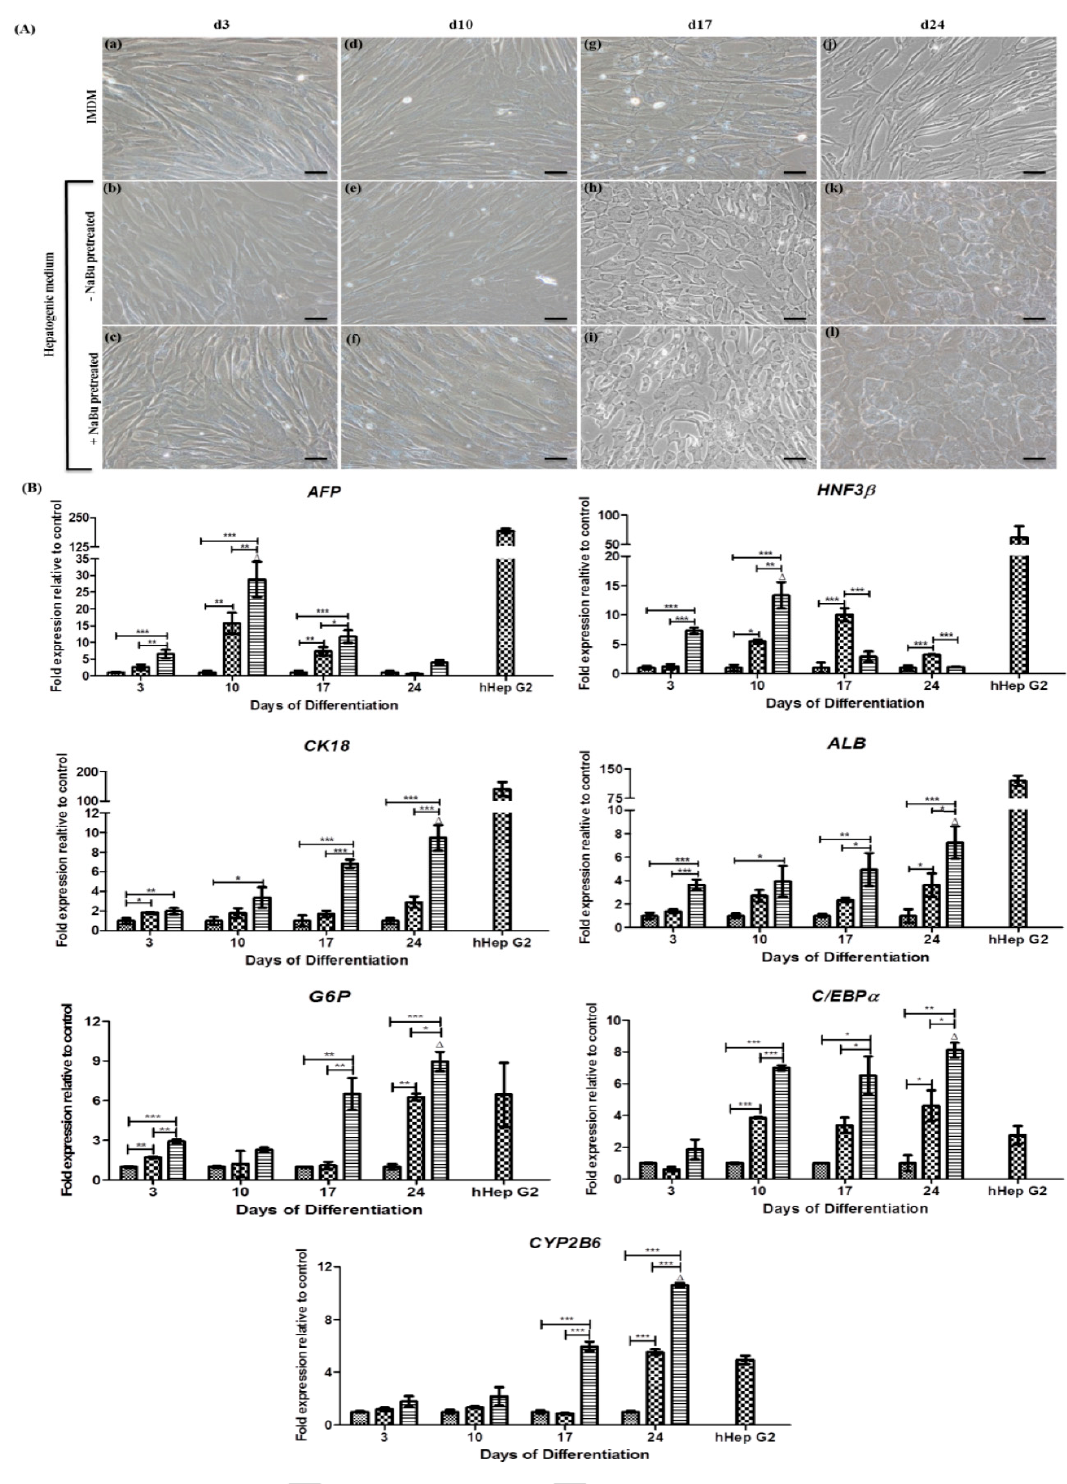
Figure 5. The influence of sodium butyrate (NaBu) along with epidermal growth factor (EGF) and basic fibroblast growth factor (bFGF) on the hepatogenic differentiation capacity of human Wharton’s jelly–derived mesenchymal stem cells (hWJ–MSCs). ( A ) Hepatic–like cell features of the differentiated hWJ–MSCs for 24 days of differentiation. hWJ–MSCs and differentiated hepatocyte–like cell morphology, with and without NaBu pre–treatment and EGF and bFGF supplementation at day 3 ( a – c ), 10 ( d – f ), 17 ( g – i ), and 24 ( j – l ), was observed using a phrase–contrast microscope, following the differentiation period. (Original magnifications 200×, bar = 50 μ m). ( B ) A real–time polymerase chain reaction (RT–PCR) analysis of hepatic–specific gene expression in differentiated hWJ–MSCs with and